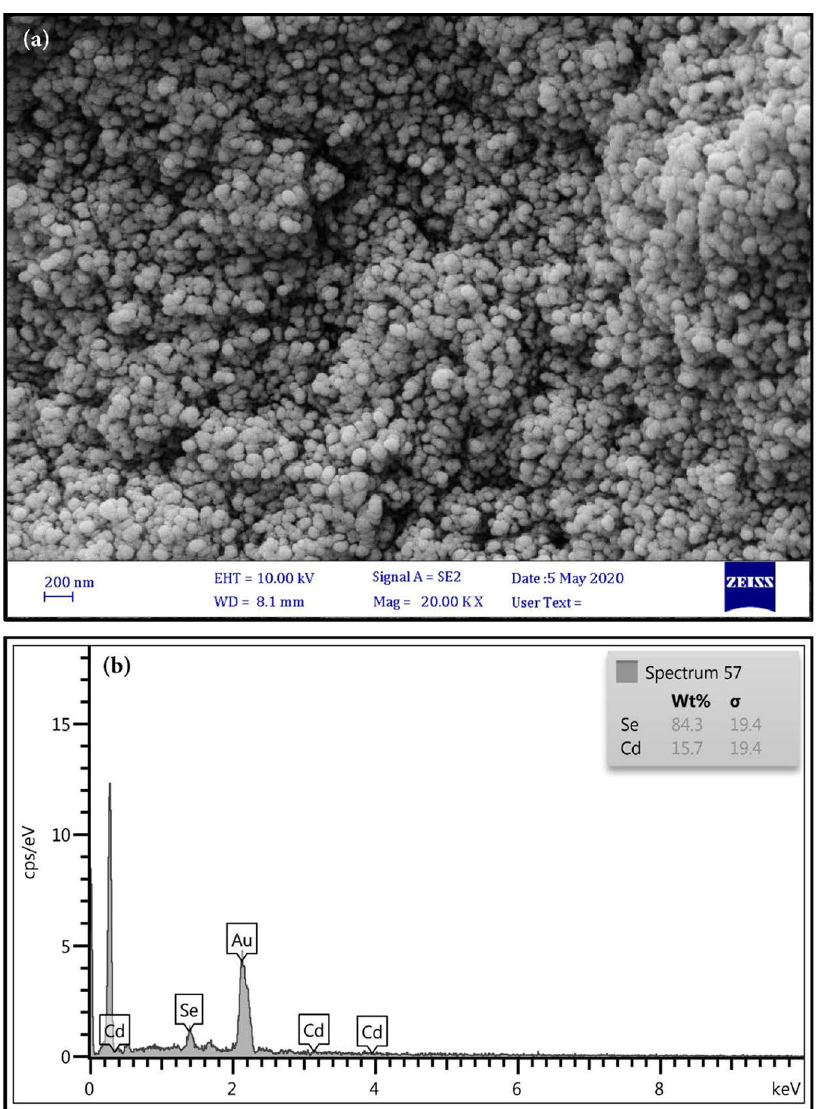
Fig. 2 Field emission scanning electron microscopy (FESEM) and Energy Dispersive Spectroscopy (EDX) of CdSe nanoparticles. a FESEM and b